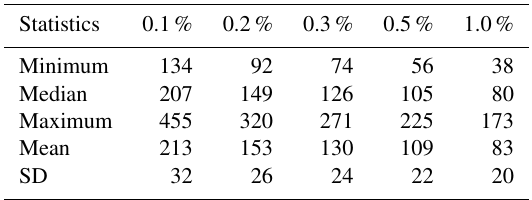
Table 3. Ranges, medians and means with SDs of the effective criti- cal dry particle diameter (in nm) at supersaturations of 0.1%, 0.2%, 0.3%, 0.5% and 1.0%.